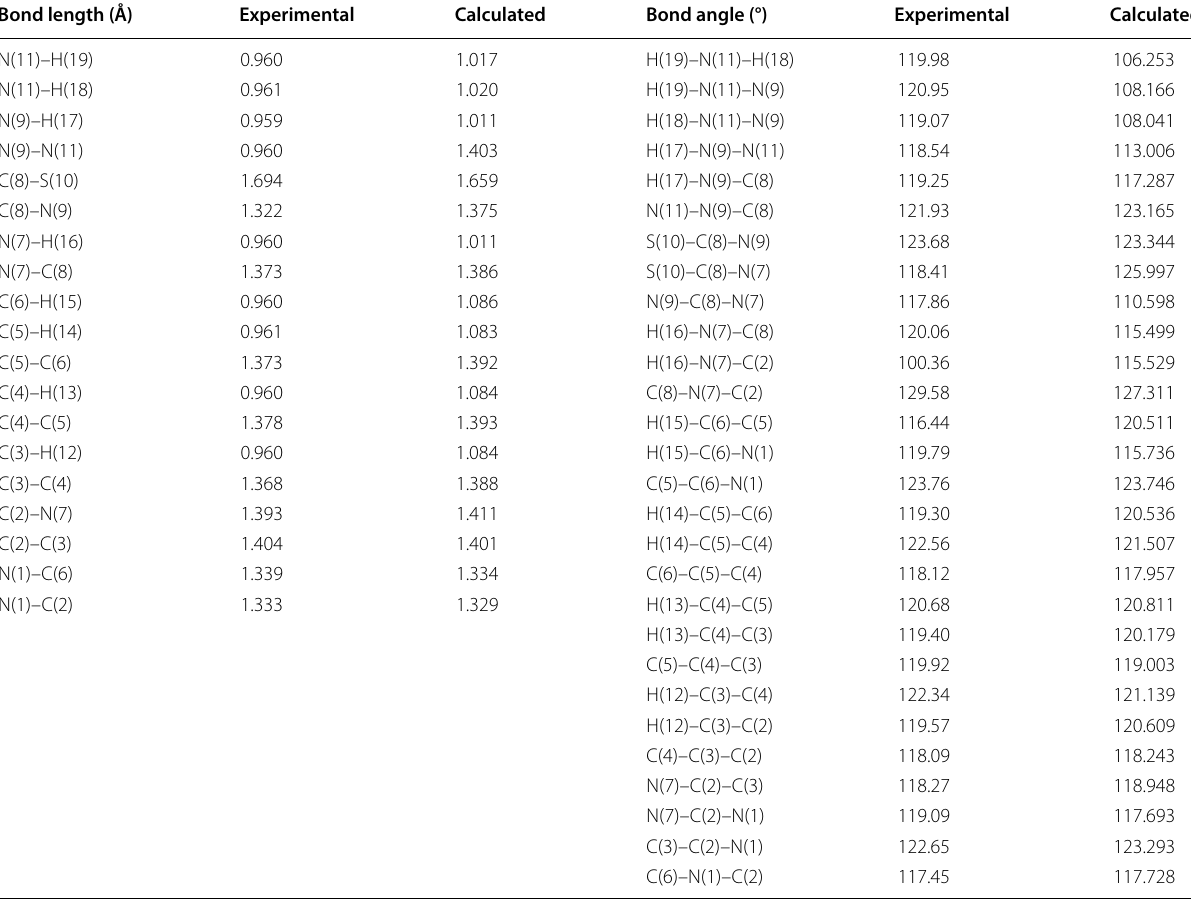
Table 4 Calculated and experimental bond lengths and angles of N